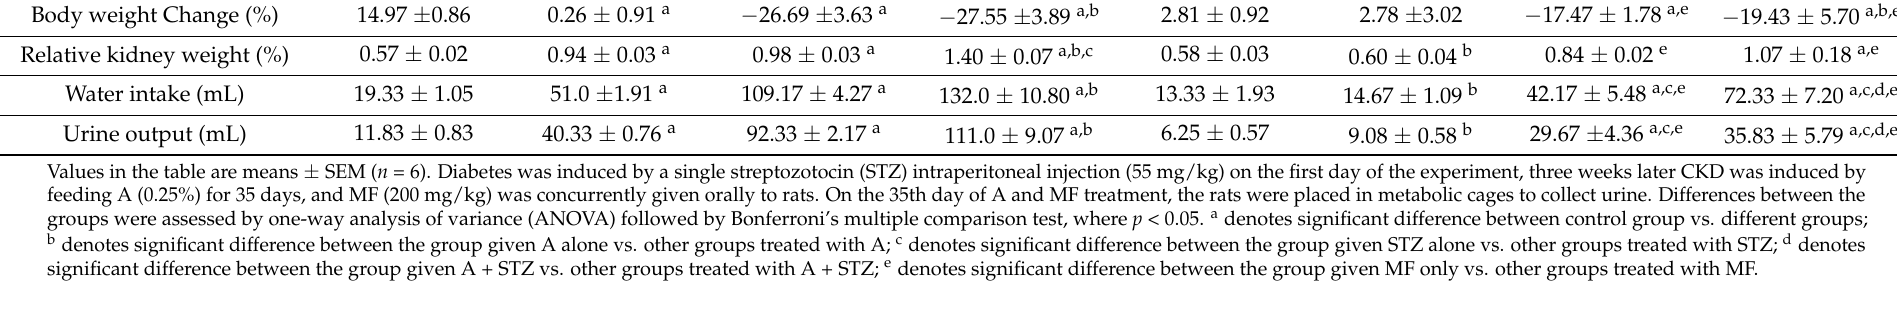
Table 2. Effect of metformin (MF) treatment on some plasma parameters in diabetic and non-diabetic rats with adenine (A)-induced chronic kidney disease (CKD).